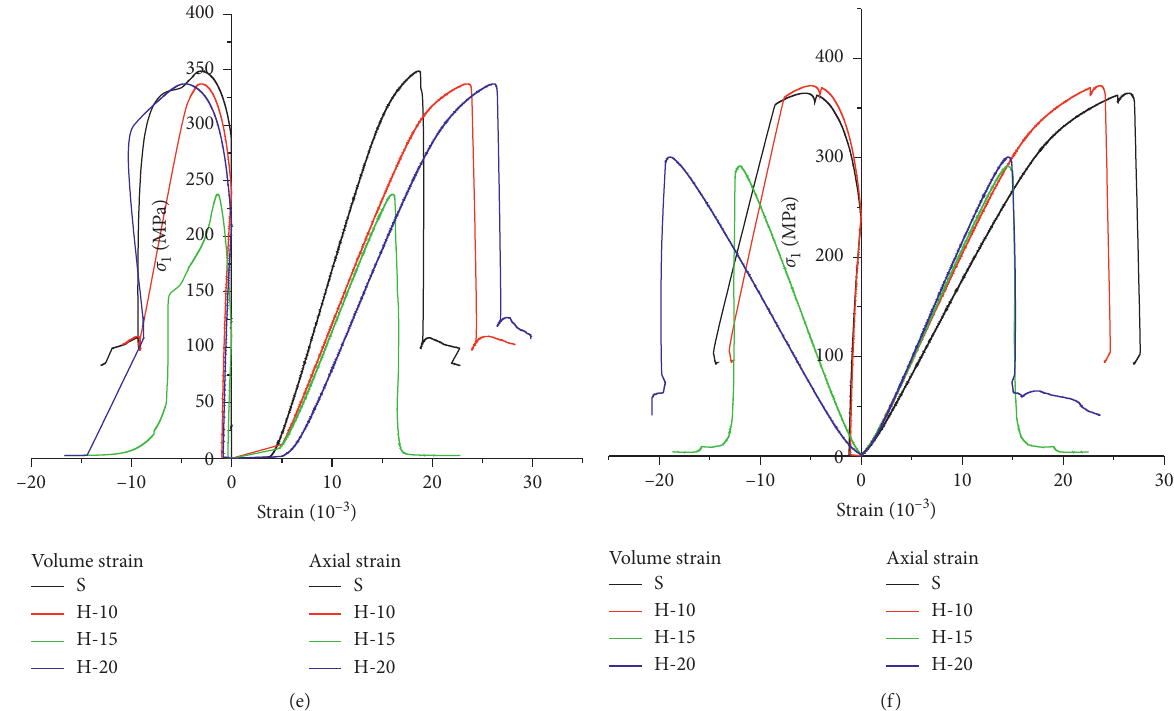
Figure 7: Triaxial compression stress-strain curve of the specimens with different pore sizes. (a) Confining pressure is 5MPa. (b) Confining pressure is 10 MPa. (c) Confining pressure is 15 MPa. (d) Confining pressure is 20MPa. (e) Confining pressure is 30MPa. (f) Confining pressure is 40 MPa.